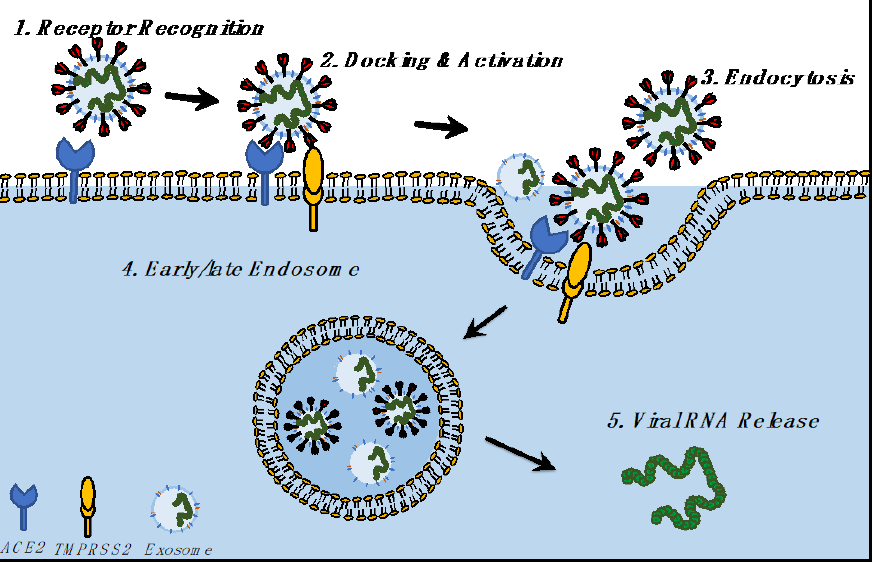
Figure 3. Hypothesis of the biological relationship between SARS-CoV-2 and exosomes, focusing on the identical mechanism followed by SARS-CoV-2 and exosomes for cellular entry and exit.